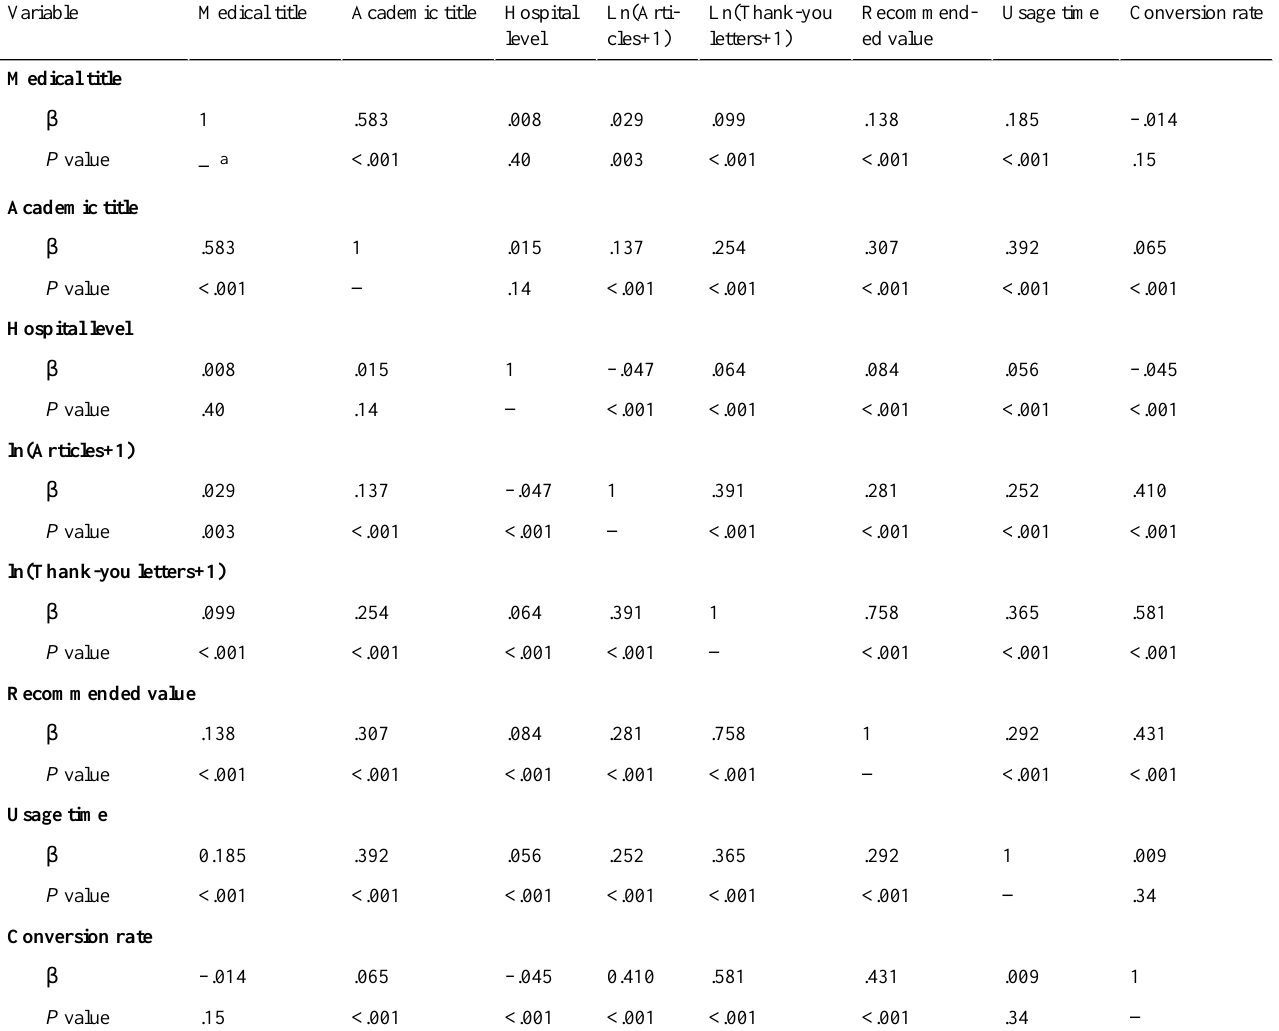
Table 3. Correlations among variables (N=10,560).